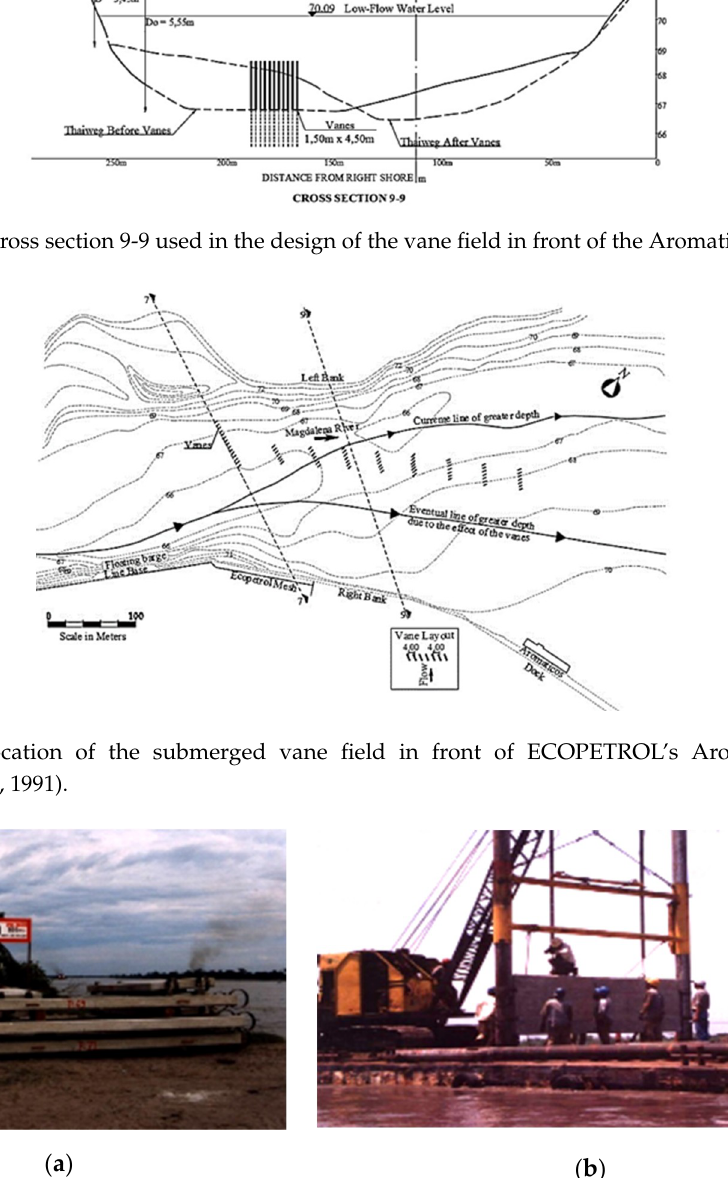
Figure 2. Cross section 9-9 used in the design of the vane field in front of the Aromatics dock.